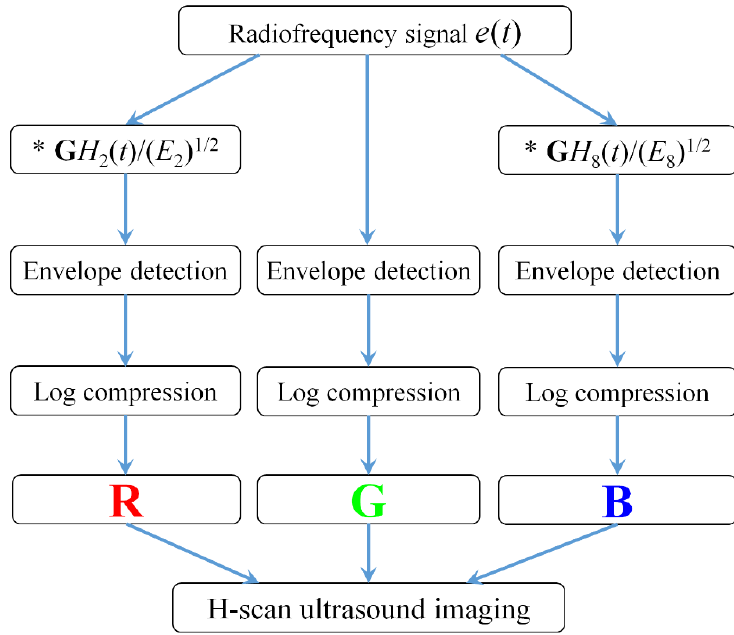
Figure 1. Flow chart of H-scan ultrasound